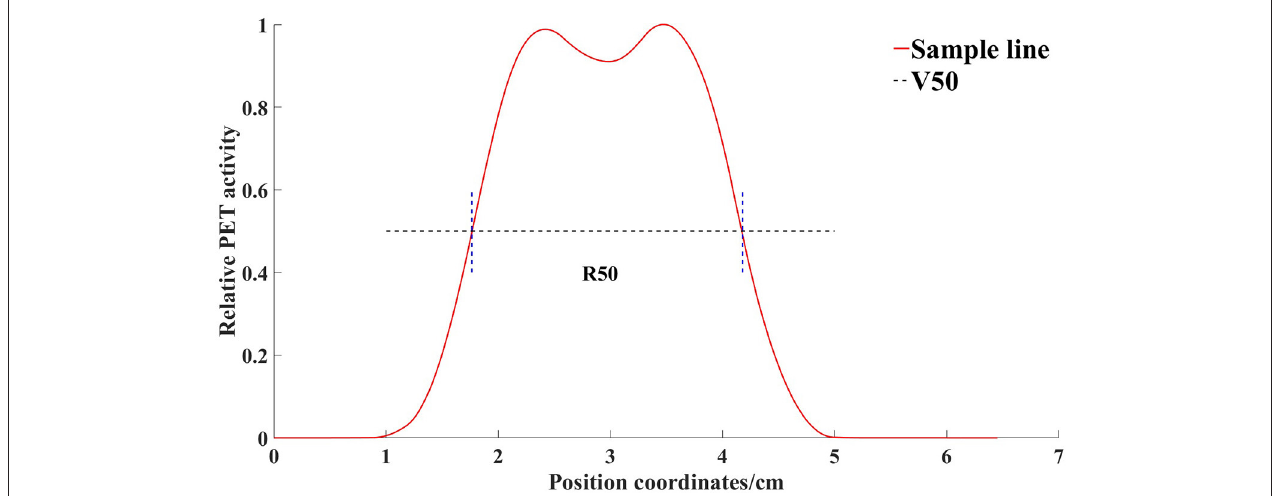
FIGURE 2 | Radioactivity distribution curve of a line through the center of the container obtained by the sampling line. V50 is the horizontal line where half of the maximum value is located. R50 refers to the distance between the points where the anterior and posterior two functional values are equal to half of the peaks, in one peak of the